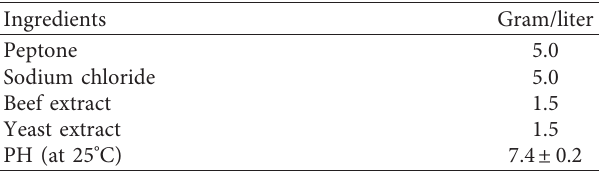
Table 6: Amount (in gm/ltr) of ingredients used in the preparation of nutrient broth.